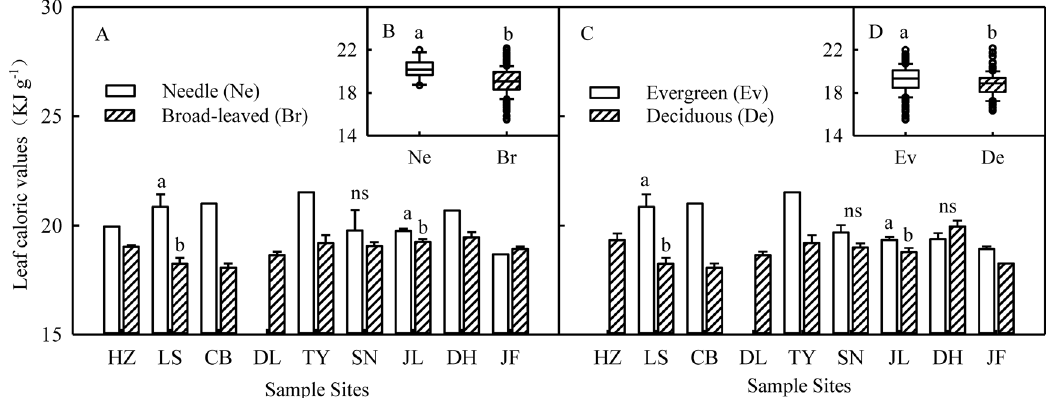
Fig 3. Changes in leaf caloric value among different types of trees in Chinese forests. Panel A, C and B, D were calculated at each site and for the total transect, respectively. Data are represented as mean ± S.E. Different letters indicate a significant difference among plant functional types ( p <